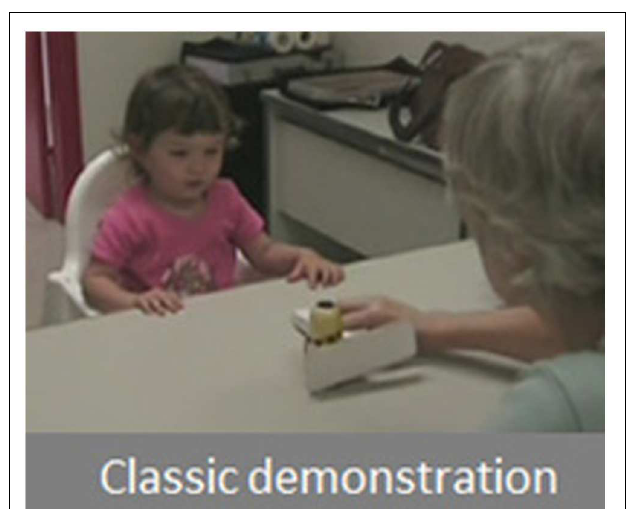
trials. In the cross-sectional study, where each child had only one